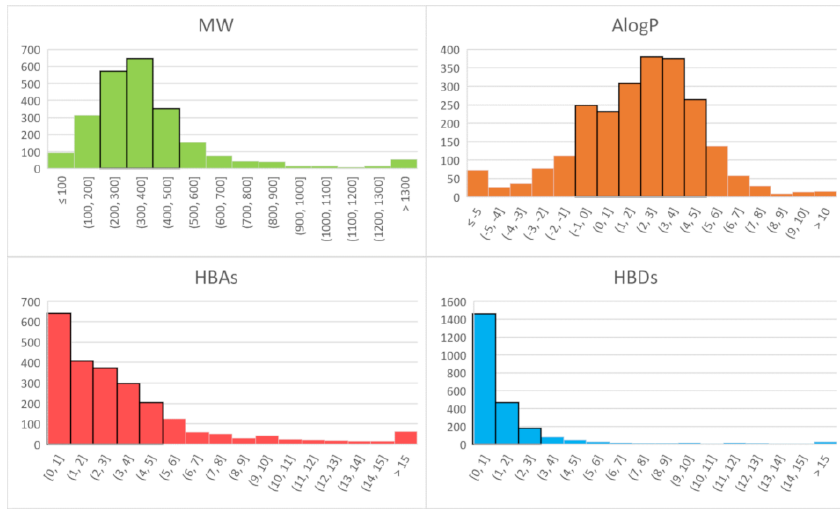
Figure 4. Distribution of molecular descriptors defining the RO5 among approved drugs (DrugBank v. 5.1.1). MW, AlogP, HBD and HBA values at physiological pH have been calculated with Maestro